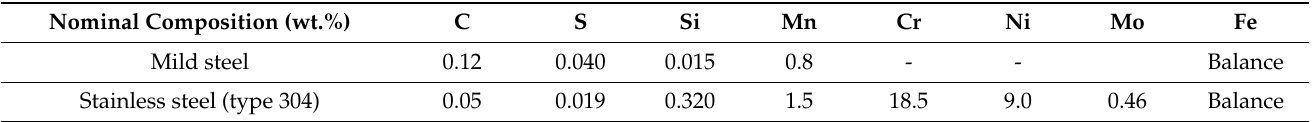
Table 1. Nominal compositions of mild steel and 304 stainless steel.